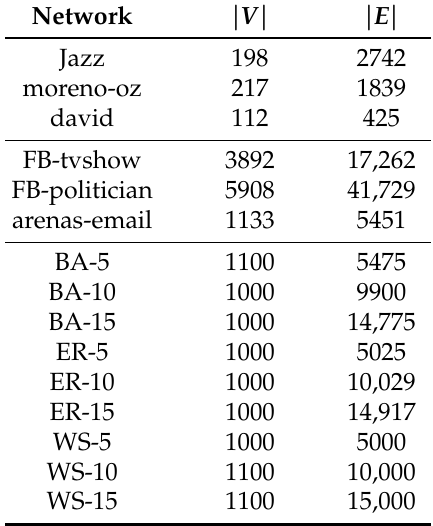
Table 6. Datasets used in comparing greedy solution with the other